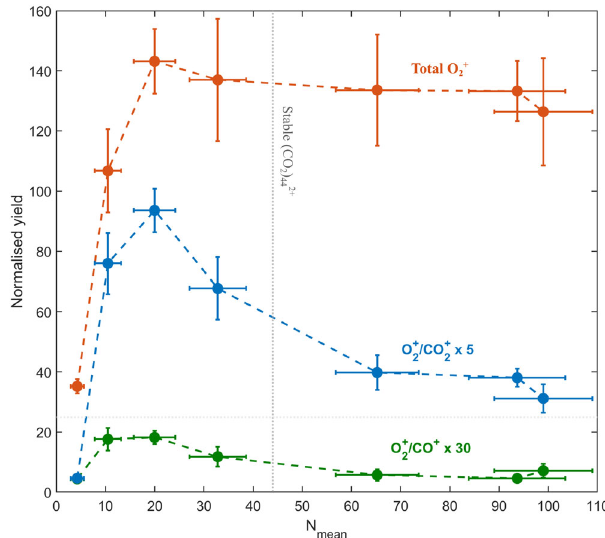
Fig. 5 Relative increase of O þ yield from CO 2 clusters with reference to 2 yields as a function of the mean cluster CO 2 molecules. Experimental O þ 2 size ( N mean ) for events in coincidence with CO + ion (green) or CO þ (blue), and for all O þ events (red) including single ion events. The yields 2 are normalised to the O þ yield from the molecule given by the coincidence 2 = C þ . The dotted line shows the formation of a stable doubly- signal O þ 2 charged cluster above the critical size 22 of N mean =